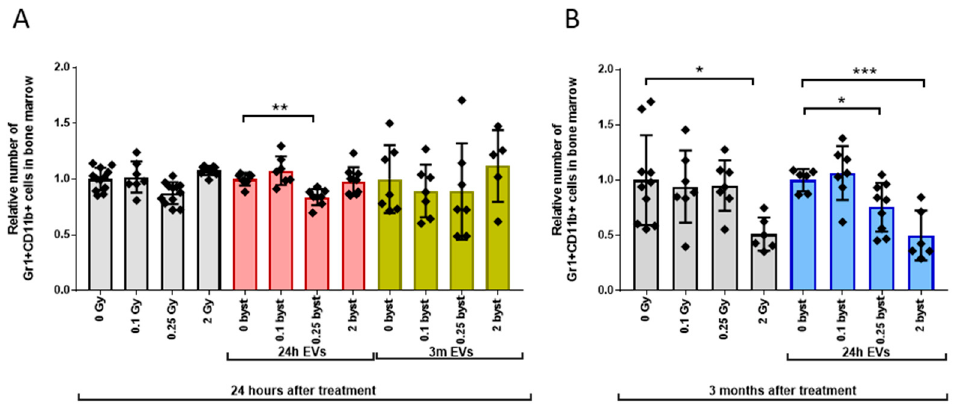
Figure 7. Long-Term Direct Radiation and Extracellular Vesicles-Mediated Bystander Effects on the Granulocytes/Monocytes Pool Are More Severe than Acute Effects. Irradiation, extracellular vesicles treatment and bone marrow cell phenotyping was carried out as described in the Materials and methods section. Gr1+CD11b+ cells were considered granulocytes/monocytes. ( A ) Relative changes in the numbers of granulocytes/monocytes were evaluated 24 h after treatment. Grey bars represent total-body irradiated mice; red bars represent mice treated with bone marrow-derived extracellular vesicles isolated from mice 24 h after irradiation; yellow bars represent mice treated with bone marrow-derived extracellular vesicles isolated from mice 3 months after irradiation. ( B ) Relative changes in the numbers of granulocytes/monocytes were evaluated 3 months after treatment. Grey bars represent total-body irradiated mice; blue bars represent mice treated with bone marrow-derived extracellular vesicles isolated from mice 24 h after irradiation. Bars represent mean values of relative granulocytes/monocytes progenitor numbers, dots show individual values, error bars represent SD. n = 5–11, significance tested by Student’s t -test, p * < 0.05, p ** < 0.01, p *** < 0.001.